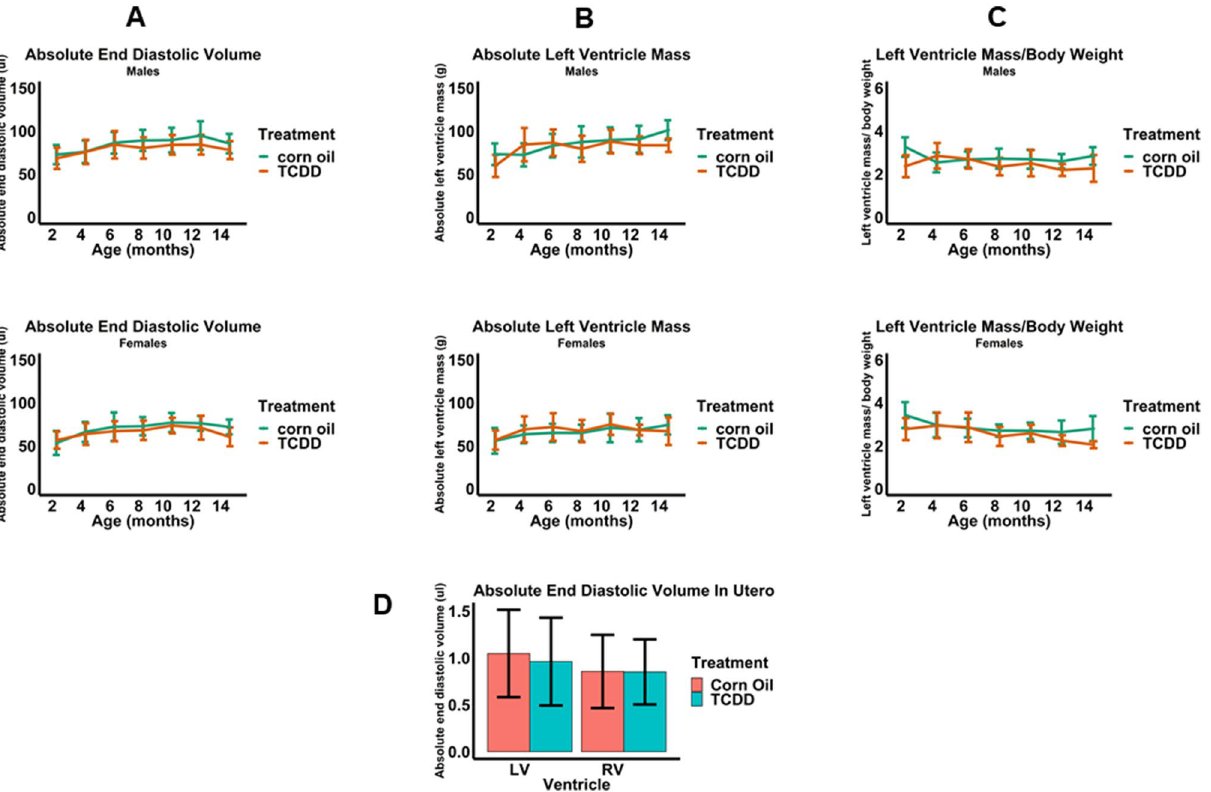
Figure 2. Echocardiographic assessment of cardiac structure after continuous exposure to TCDD for 14 months. End diastolic volume ( A ), absolute left ventricle mass ( B ), and left ventricle mass normalized to body weight ( C ) were assessed in males and females after 14 months of continuous exposure to TCDD. End diastolic volume was assessed after exposure to TCDD in utero at E15.5 ( D ). All data are expressed as mean + SD.